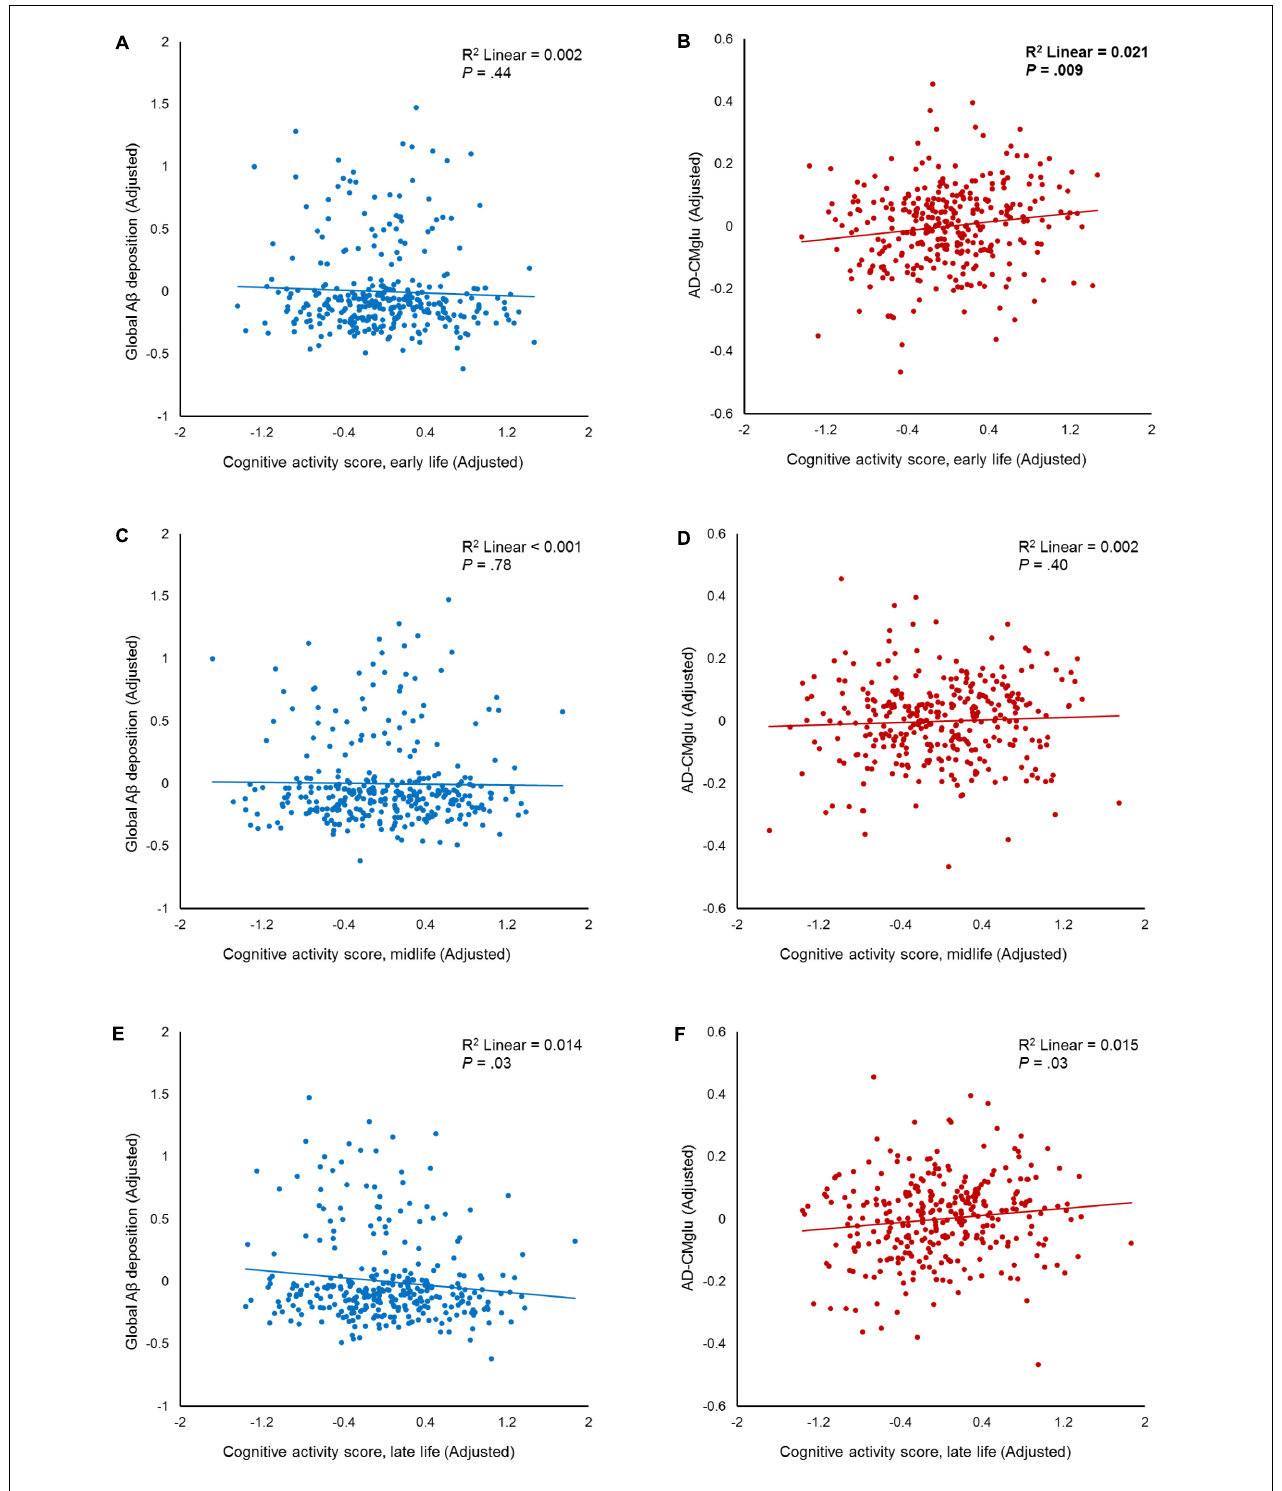
FIGURE 1 | Partial regression plots showing the effect of participating in cognitive activity (CA) during each life period. The results of the independent multiple linear regression model with age, gender, education, and apolipoprotein E ε 4 as covariates are presented. (A,B) Plots for early-life CA (CA early ) and amyloid-beta (A β ), as well as for Alzheimer’s disease signature region cerebral glucose metabolism (AD-CMglu). A significant association was observed between CA early and AD-CMglu, but not A β . (C,D) Plots for midlife CA (CA mid ) and A β , as well as for AD-CMglu. (E,F) Plots for late-life CA (CA late ) and A β , as well as for AD-CMglu.